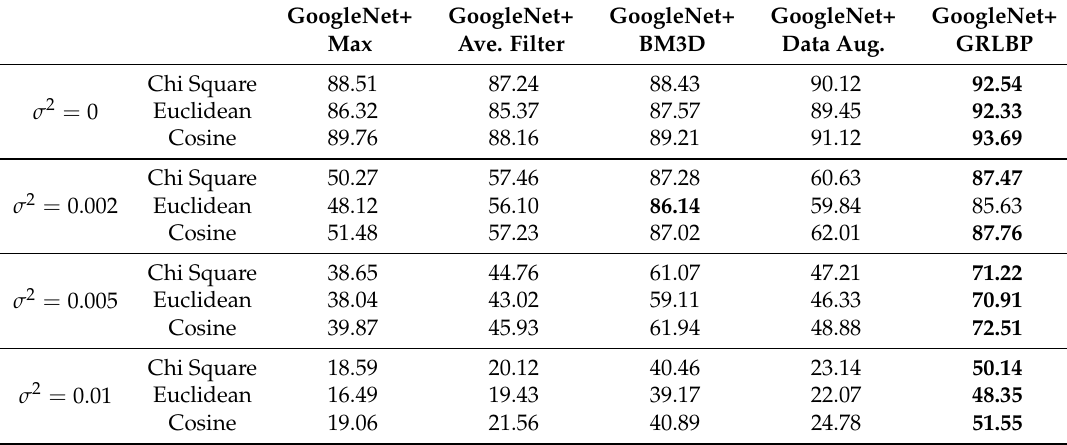
Table 8. The recognition rates (%) of different pooling methods, the average filter, the BM3D algorithm, and data augmentation based on the GoogleNet on the ORL database with different Gaussian